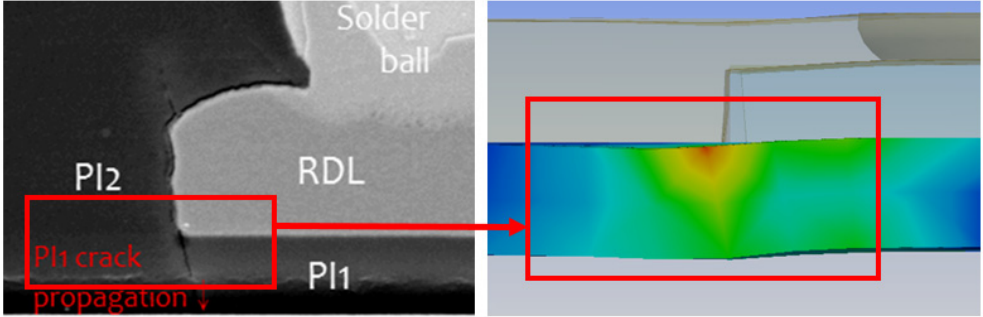
Figure 8. Cross-section morphology of experimental and simulation comparison.